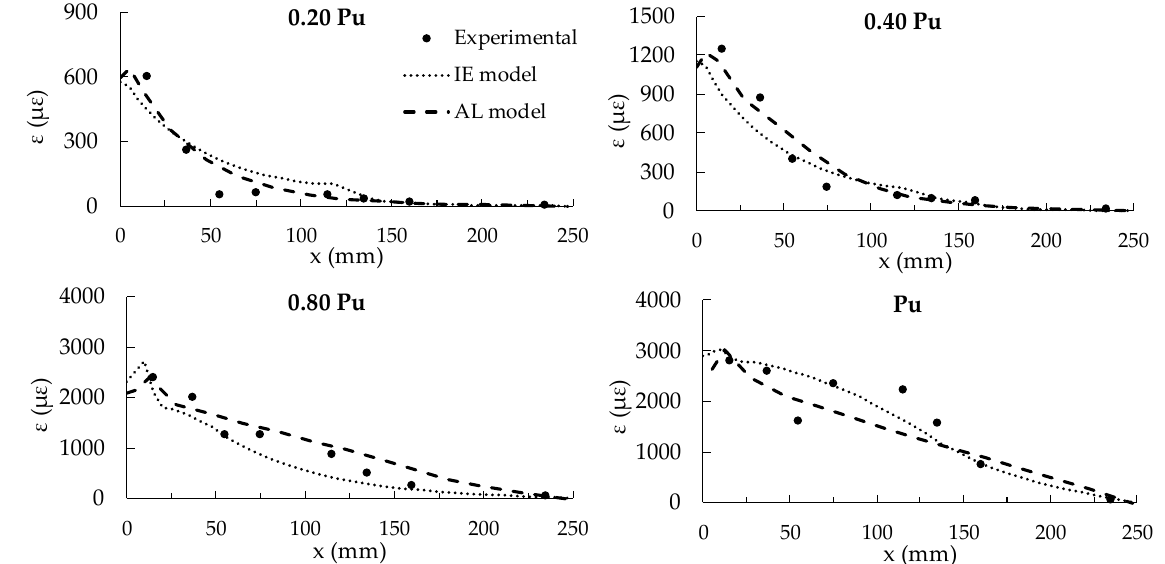
Figure 6. Experimental vs. numerical strain distributions provided by IE and AL FE models for specimen C30_1.4_50_250 tested in [9].